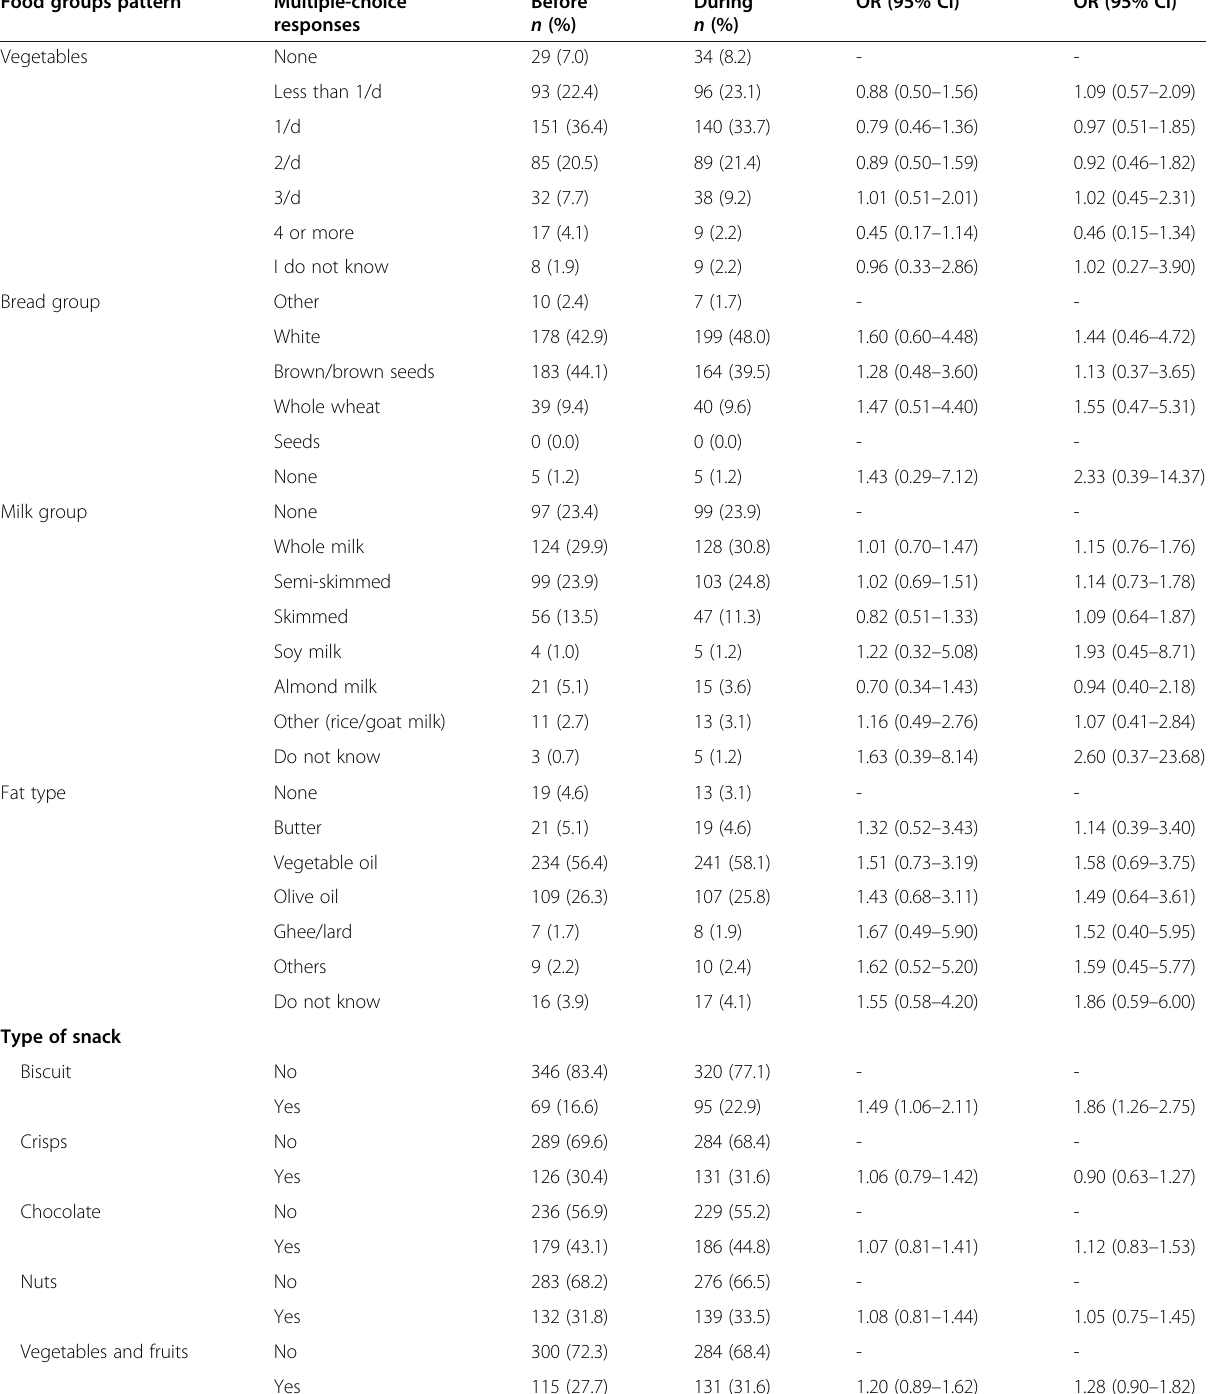
Table 3 Multivariate analysis between two periods using logistic regression for food groups pattern (Continued) Food groups